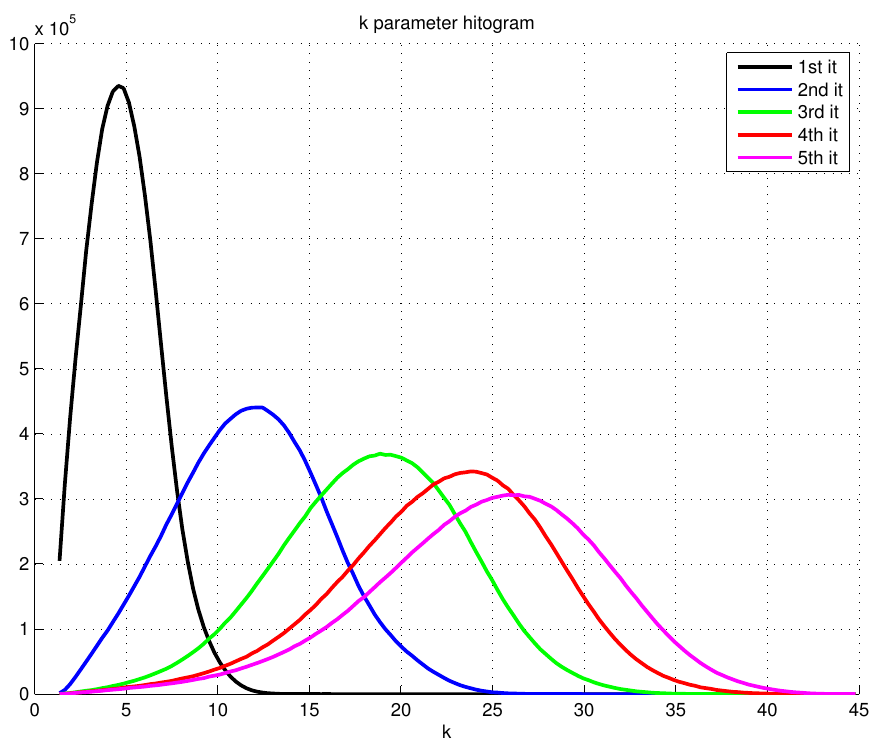
Figure 6. Number of averaged pixels (the k parameter) histogram for each